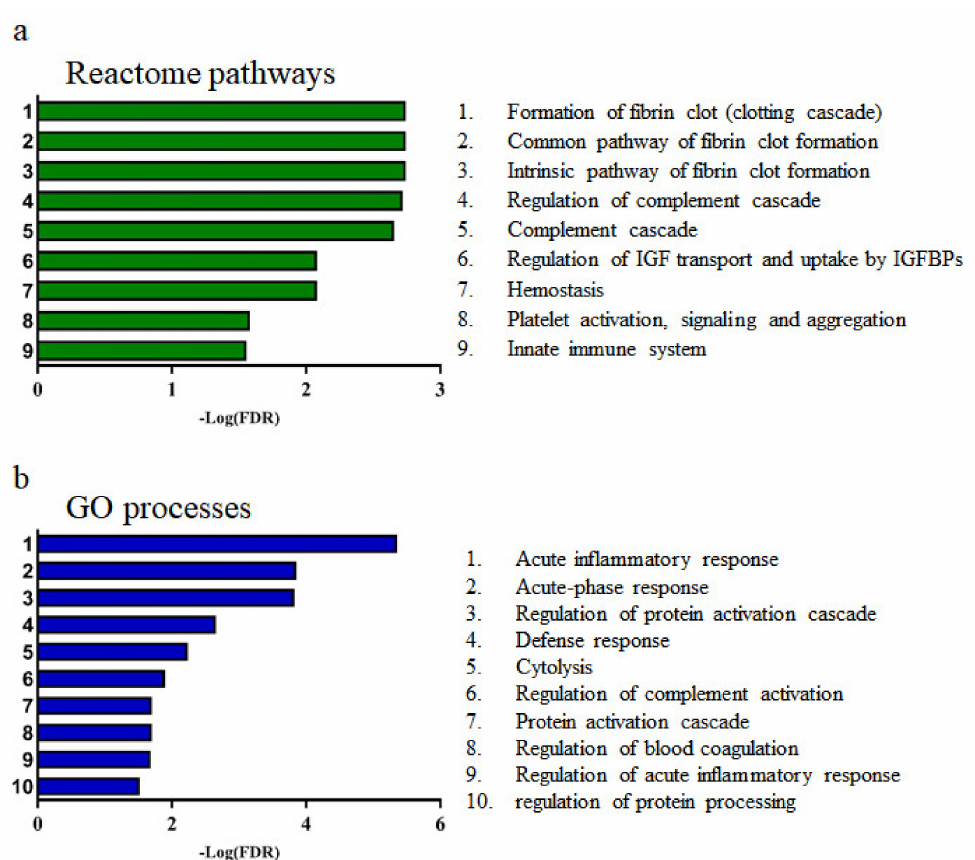
Figure 3. Reactome pathways and GO processes associated with proteins that are differently expressed in depression status and remission status. ( a ) Results of reactome pathways related to candidate proteins. ( b ) Results of GO processes related to candidate proteins. The X and Y axes represent the –log (FDR) and ranking of the lower FDR, respectively. The lower FDR denotes a strong association with MDD and its